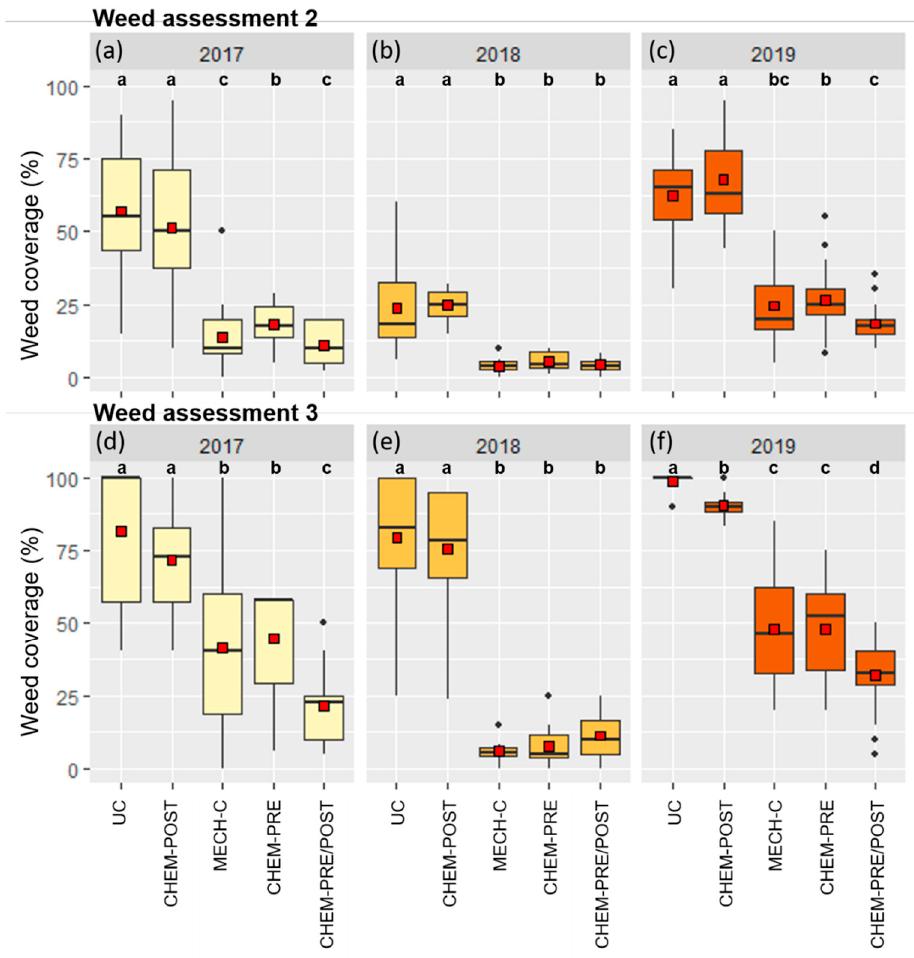
Figure 2. Weed coverage (%) for the different methods of weed control in 2017 to 2019. ( a – c ): Weed assessment 2 (after the pre-emergence bean herbicide application). ( d – f ): Weed assessment 3 (14 days after the post-emergence herbicide application). Kruskal-Wallis Test: different letters represent significant differences ( p < 0.05) between the different methods of weed control.